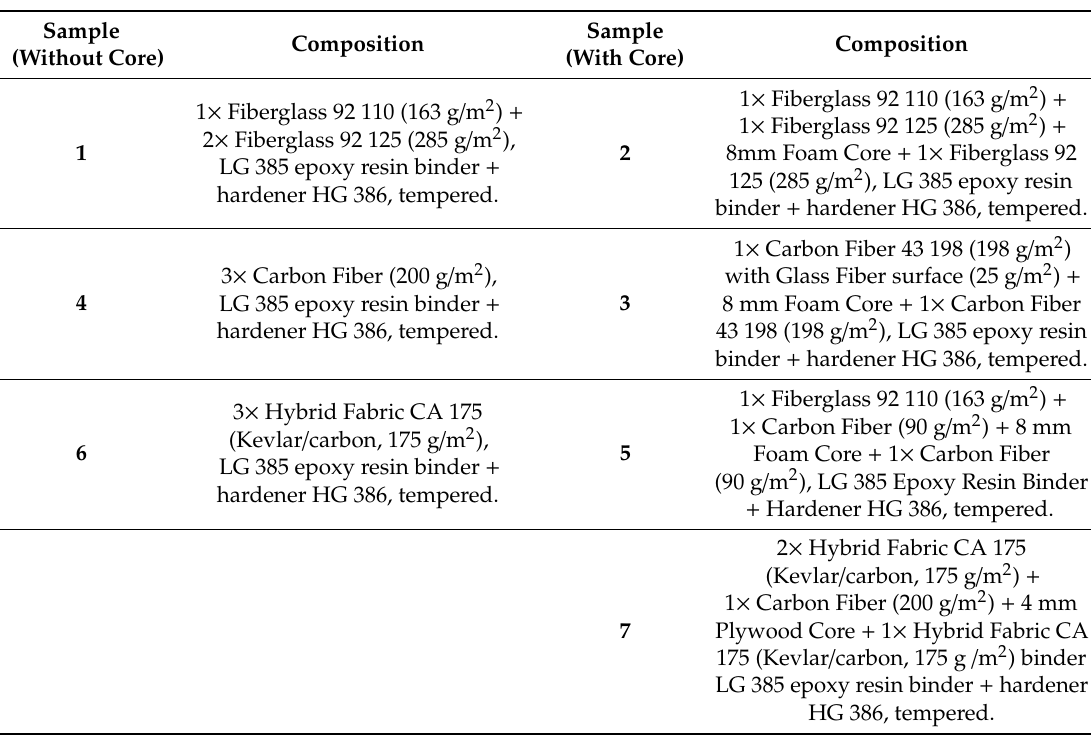
Table 1. List of